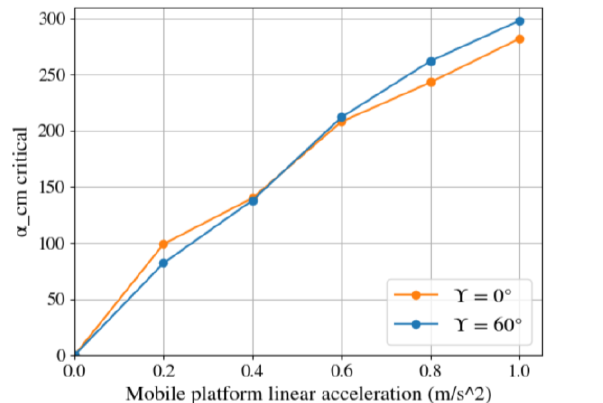
Figure 13. Critical tilting instability for different values of ϒ as a function of the mobile platform traveling acceleration.